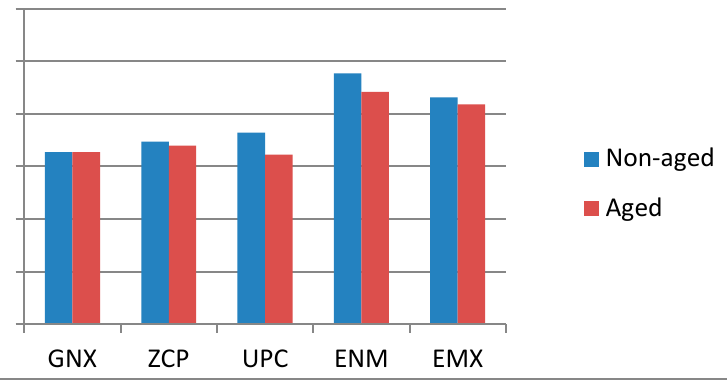
Figure 5. TP values of materials within same material group; non-aged and aged.